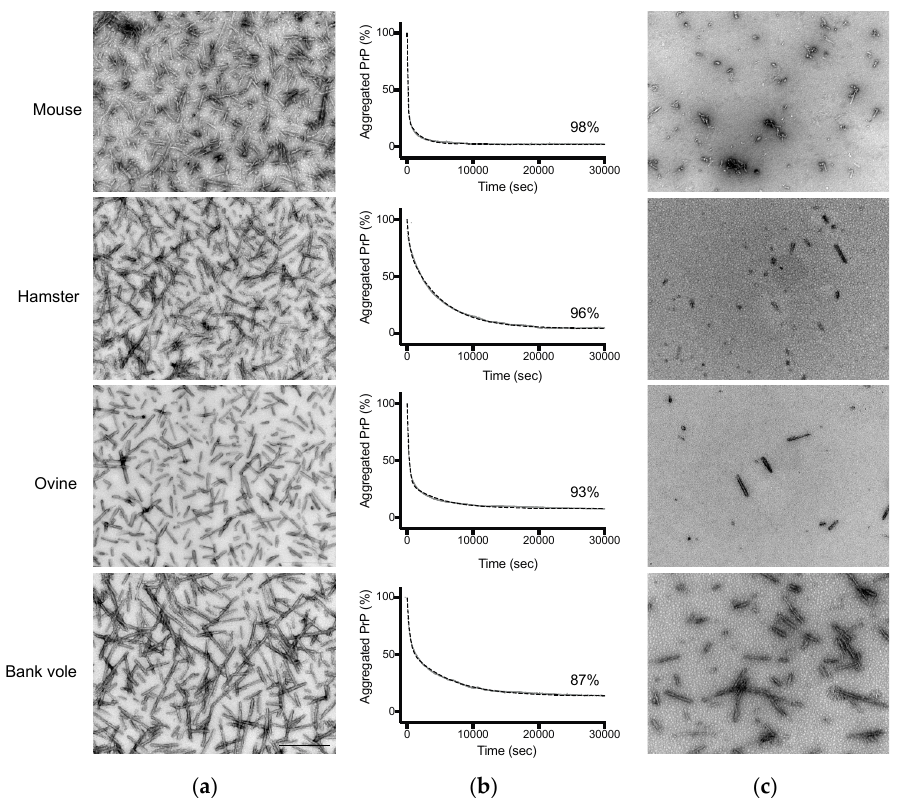
Figure 1. Pressure dissociates PrP fibrils and alters their macrostructure. Negative stained transmission electron microscopy micrographs of ( a ) untreated (8 h at 25 °C) PrP fibrils; and ( c ) after a cycle of compression (360 MPa, 8 h)/decompression at 25 °C. Scale bar, 500 nm. ( b ) The kinetics of the pressure-induced PrP fibril dissociation were recorded as a decrease in light scattering. Fibril fraction was calculated from the amount of resolubilized PrP rescued after the pressure treatment, as judged from the absorbance at 280 nm of the supernatants obtained after removing fibrils by centrifugation. Dashed lines, linear fits to the data.